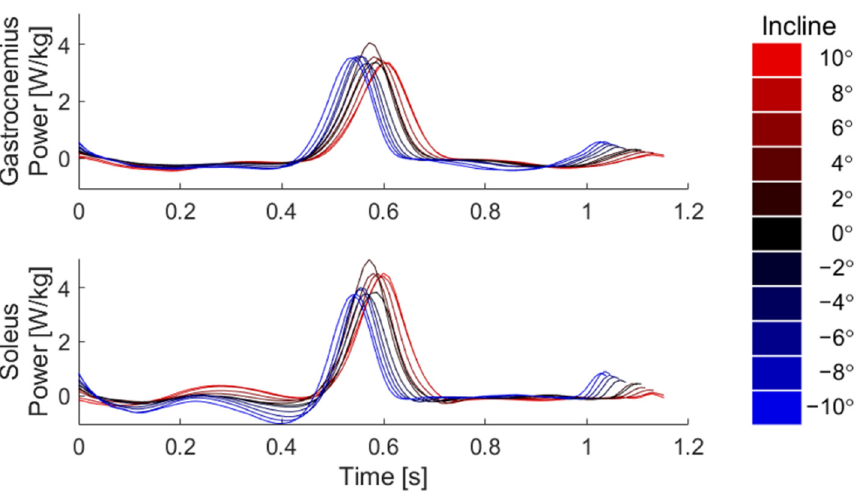
Figure 4. Muscle power derived illustrate slope-dependent differences in timing and magnitude of positive and negative work.